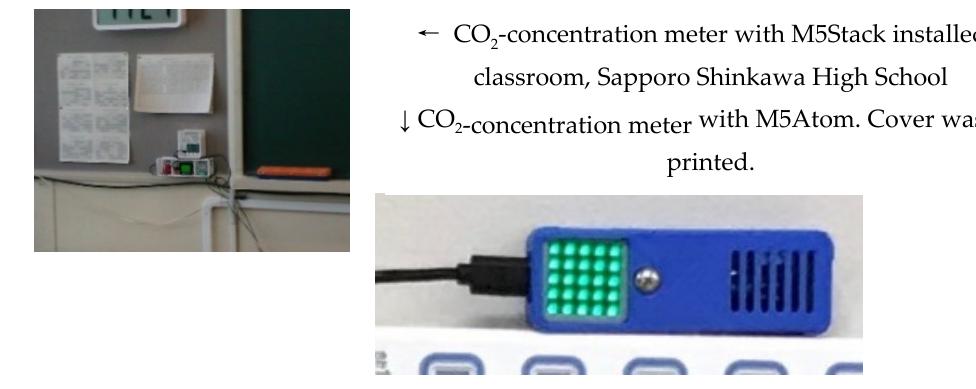
Figure 3. CO 2 -concentration meters with a warning display.